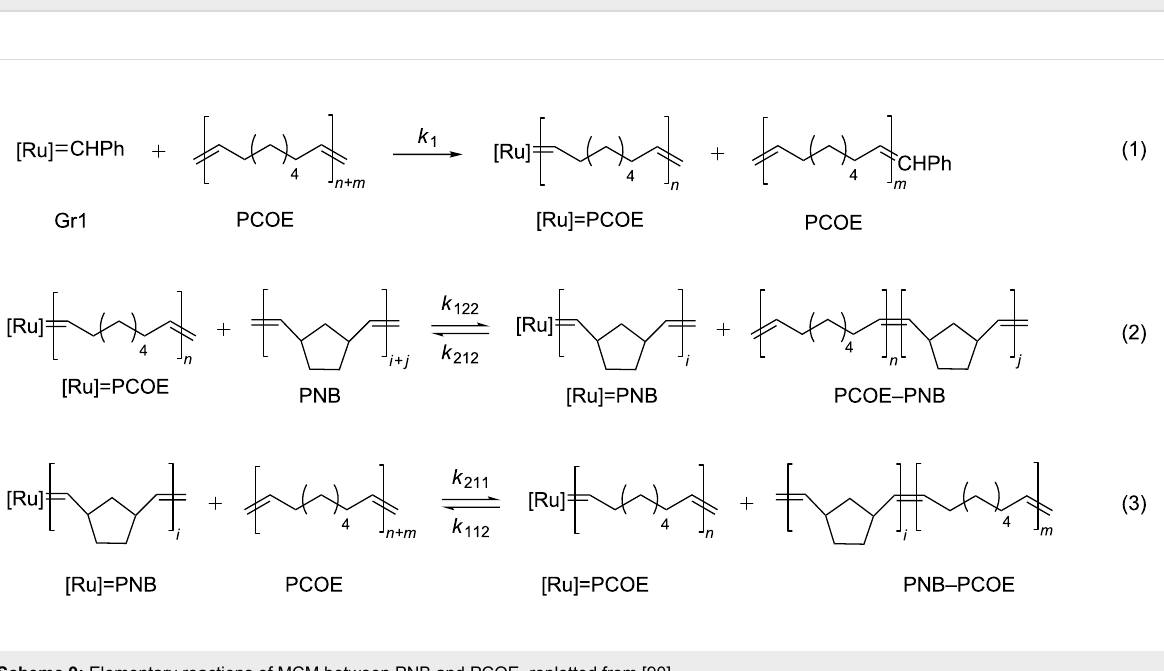
Figure 6: The 13 C NMR spectrum recorded after 8 h of the reaction between PCOE, PNB, and Gr1; the homo- and heterodyad signals are enlarged in the inset [90].